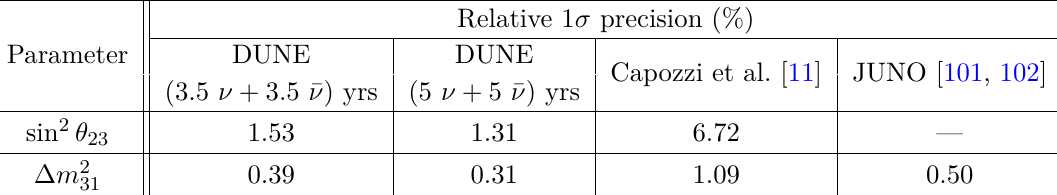
Table 4 . Relative 1 σ precision on sin 2 θ 23 and ∆ m 2 ∆ m 2 = 2 . 522 × 10 − 3 eV 2 . The second and third columns show the performance of DUNE with 7 31 and 10 years of exposures, respectively, equally divided in neutrino and antineutrino modes. The fourth coulumn depicts the current relative 1 σ precision on these parameters from the global fit study [11]. The achievable precision on ∆ m 2 mentioned in the fifth column. Note that JUNO is insensitive to θ